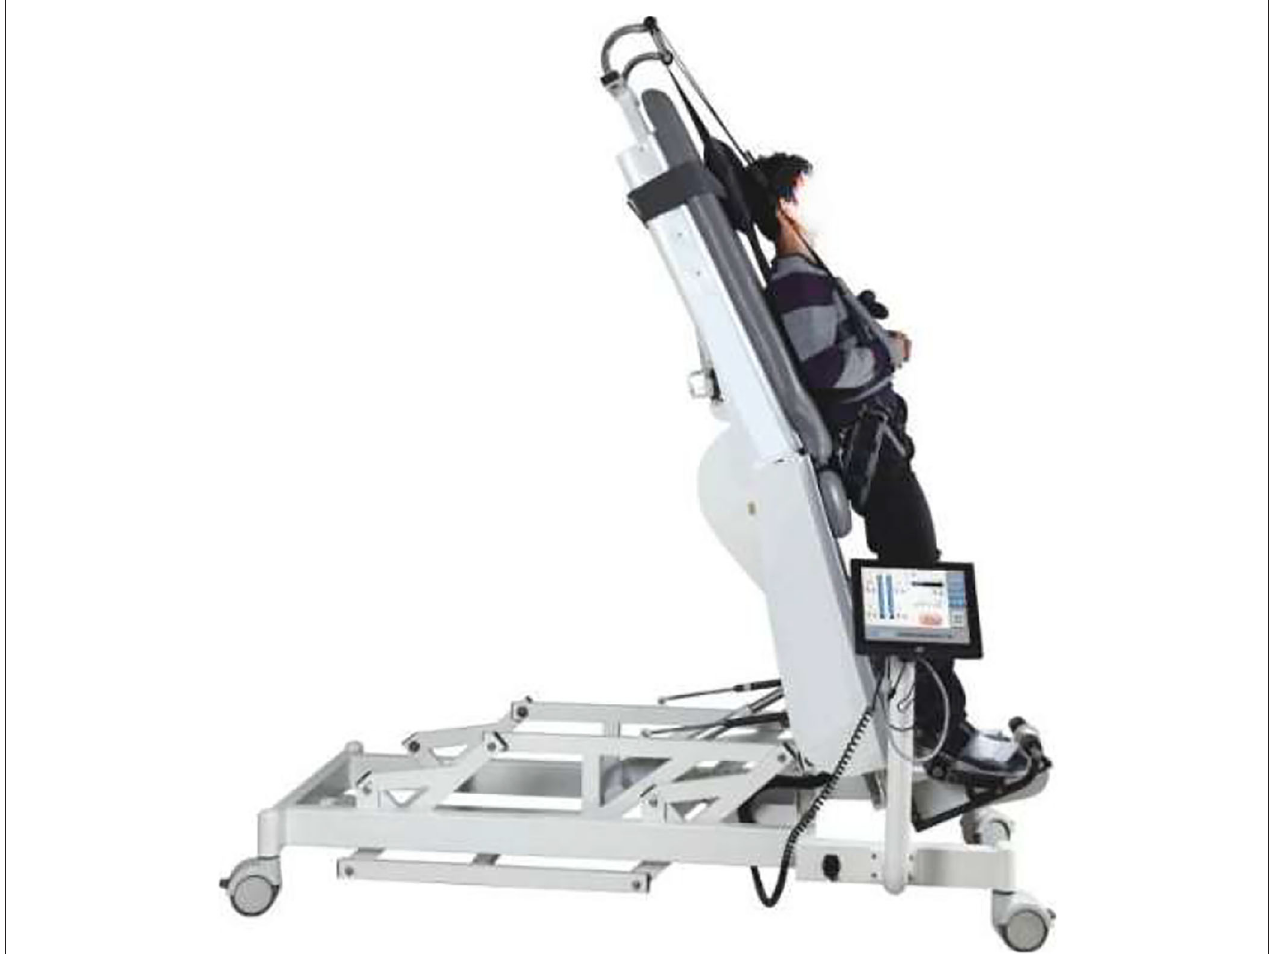
FIGURE 1 | Bed-type lower